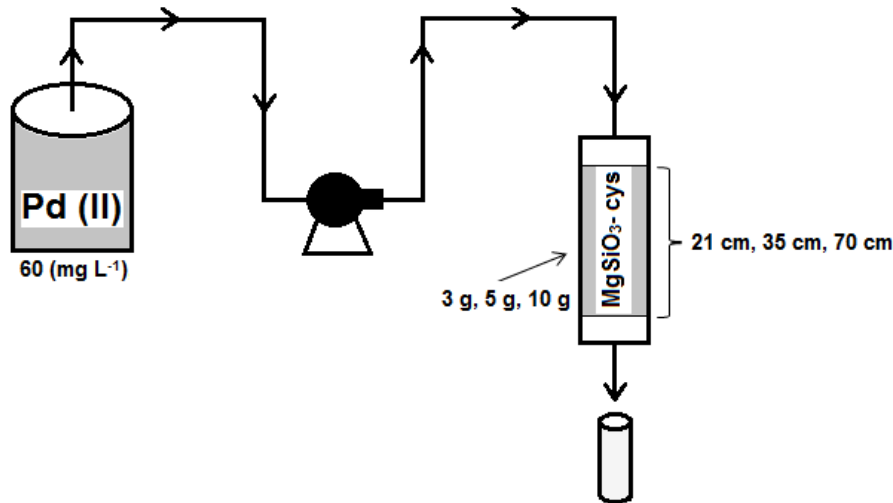
Figure 2. The scheme of the experimental Pd (II) removal installation in a fixed-bed adsorption column. For each adsorption column experiment, there were three independent